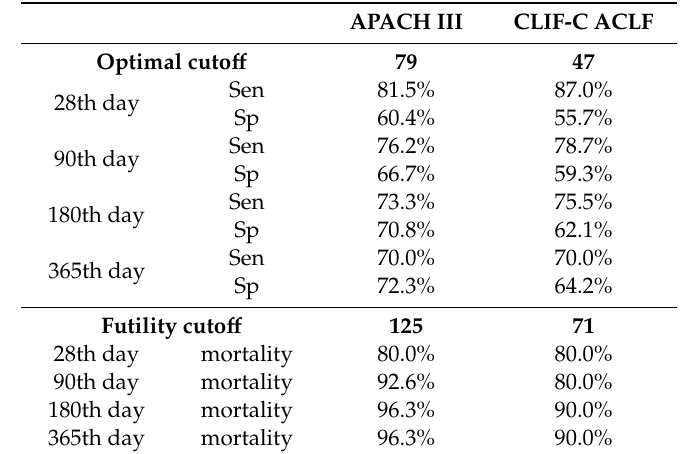
Table 4. The optimal and futility cuto ff values for APACHE III and CLIF-C ACLF scores to predict mortality and their sensitivity and specificity at di ff erent time